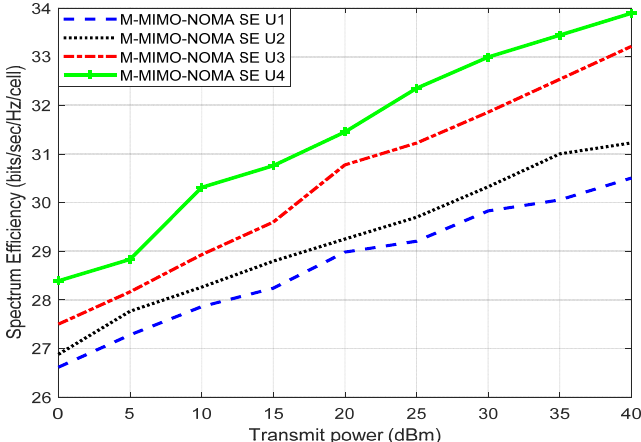
Figure 10. SE vs. transmitting power for 4 users’ 128×128 M-MIMO DL NOMA PD.